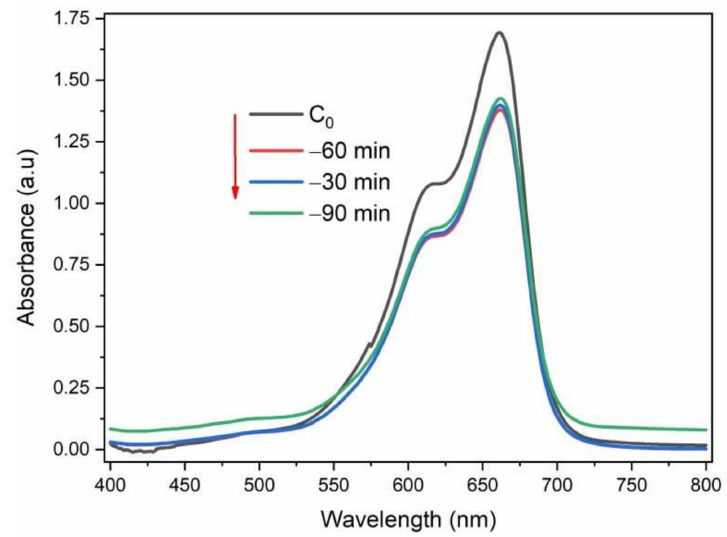
Figure 7. UV-Vis spectrum of MB after being adsorbed by ZrO 2 /CuO-doped 8 mol% Ce 3+ /Ce 4+